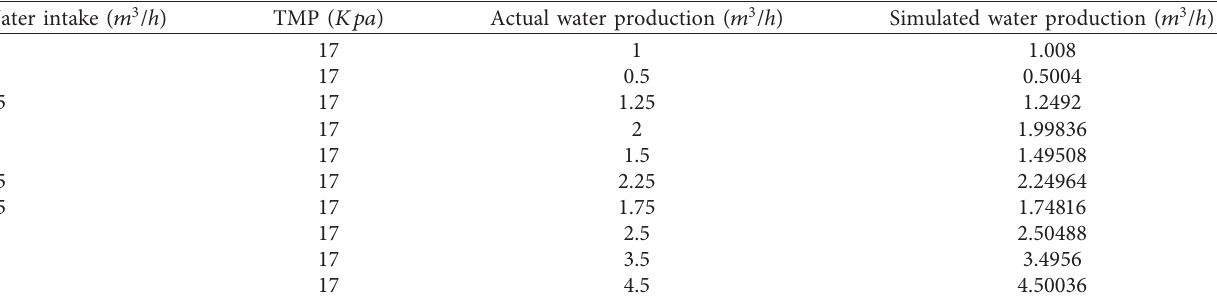
Table 1: Internal pressure series MBR system water production